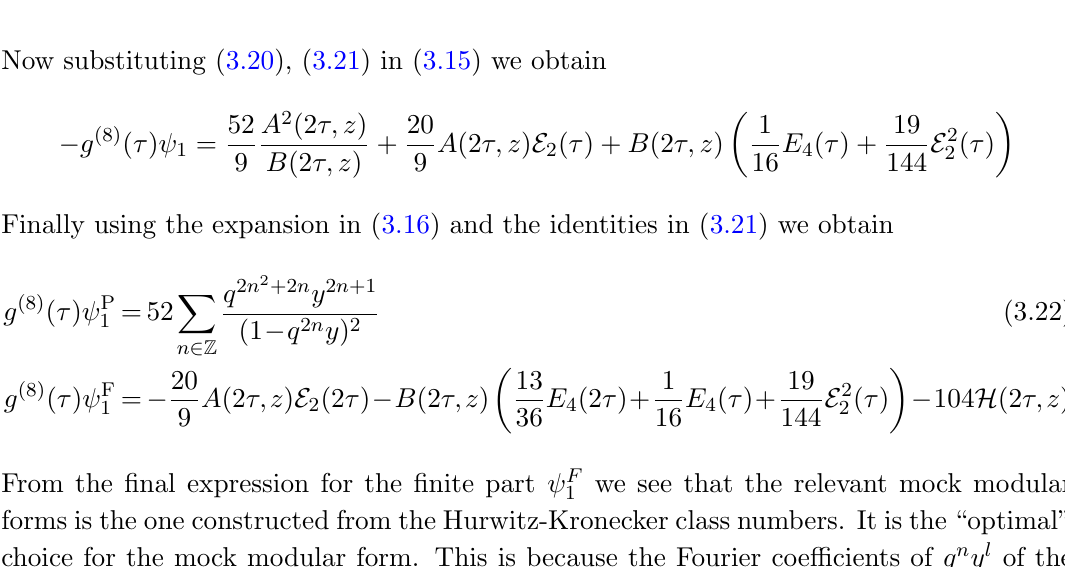
Figure 1 . Figure reproduced from [15] showing chamber R in the upper half axion-dilaton plane, bounded by the walls of marginal stability, for the un-orbifolded theory, the 2 A and the 3 A